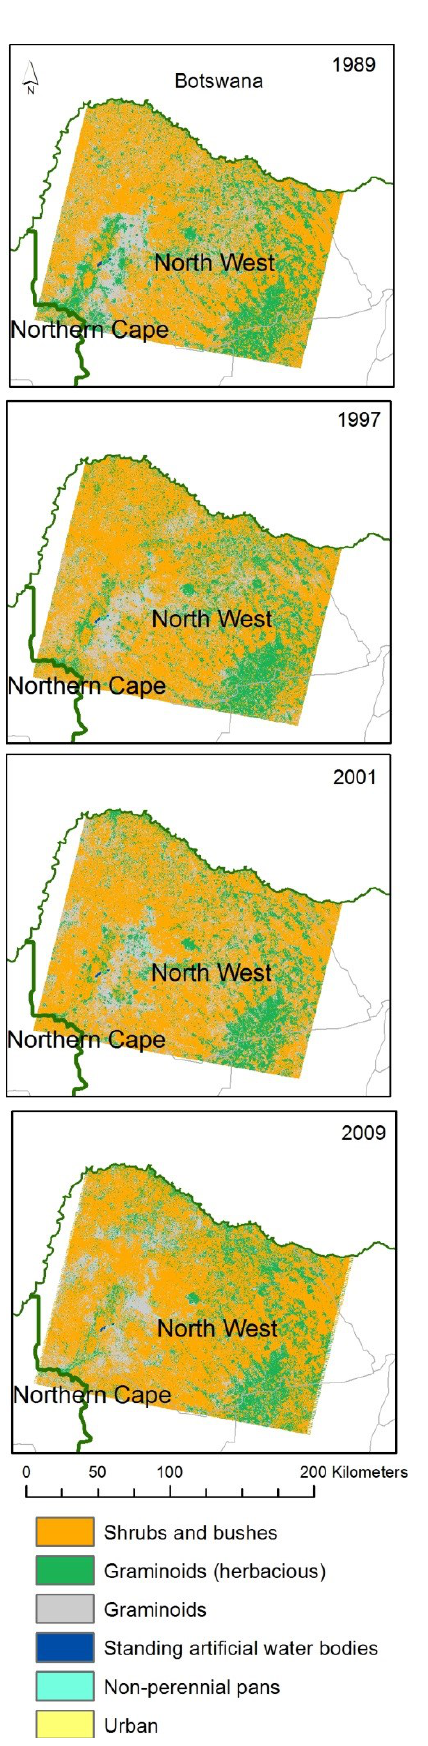
Figure 2. Land cover classifications of the four Landsat scenes